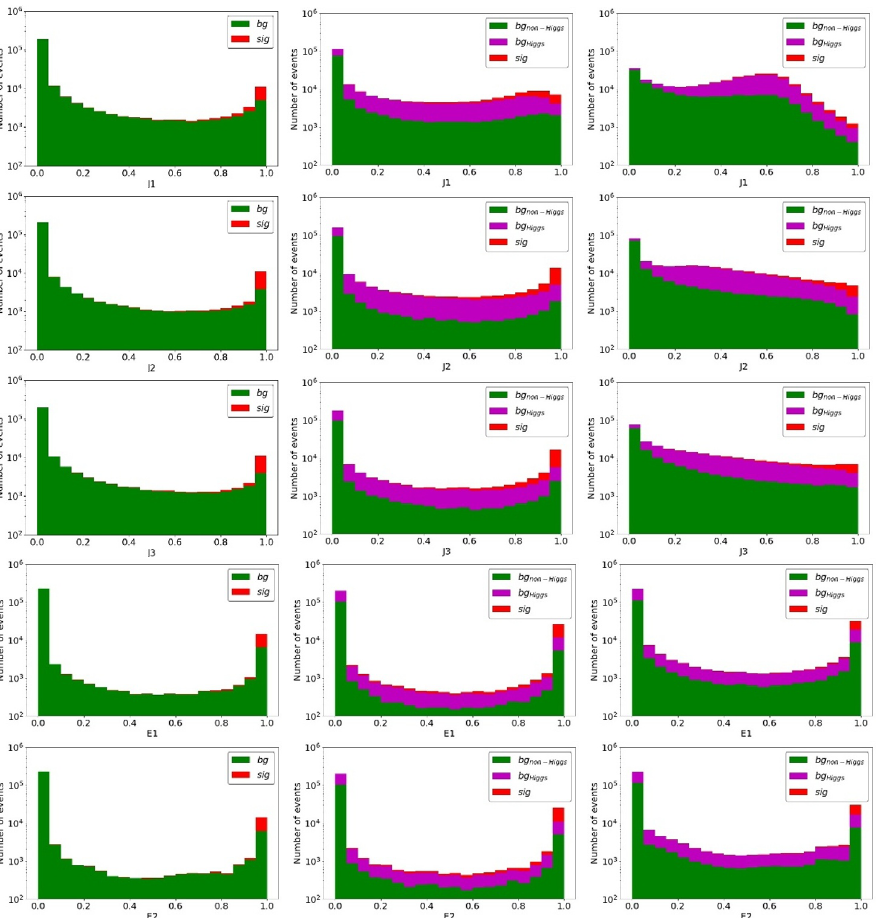
Figure 21 . Responses of the Z (cid:23) h W background events, to the binary